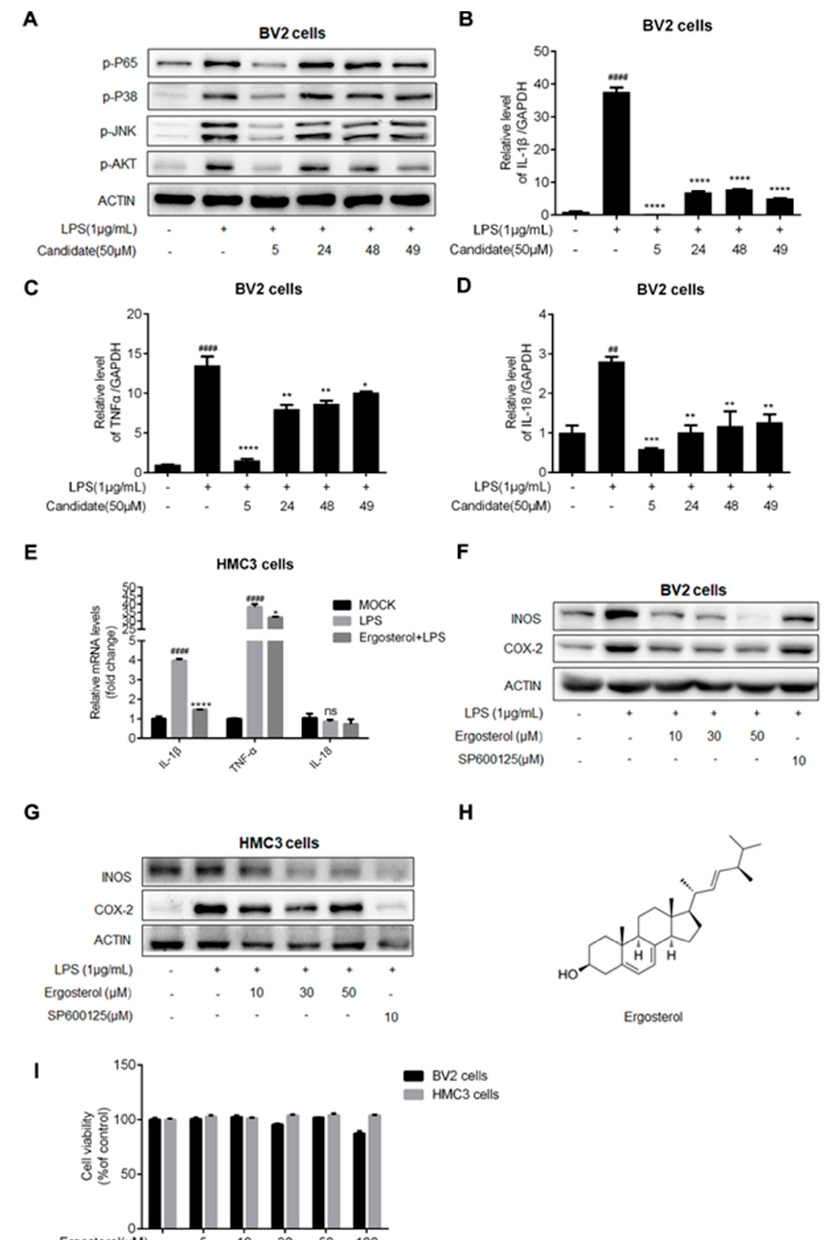
Figure 1. Ergosterol inhibits the microglial inflammation induced by LPS treatment. ( A ) BV2 cells pretreated with a natural compound for 2.5 h, and then LPS added at a final concentration of 1 µ g/mL. After 30 min, the protein levels of p-P65, p-P38, p-JNK, and p-AKT were detected using Western blot. ( B – D ) BV2 cells were incubated with Ergosterol for 2.5 h, and then, LPS was added. After 6 h, the mRNA levels of IL-1 β , TNF- α , and IL-18 were detected by qRT-PCR. ( E ) The same experimental procedure was performed in the HMC3 cells to detect the mRNA levels of IL-1 β , TNF- α , and IL-18 by qRT-PCR. ( F , G ) BV2 and HMC3 cells pretreated with Ergosterol or SP600125 for 2.5 h, followed by ( H ) Chemical name and structure of Ergosterol. ( I ) BV2 and HMC3 cells were seeded on